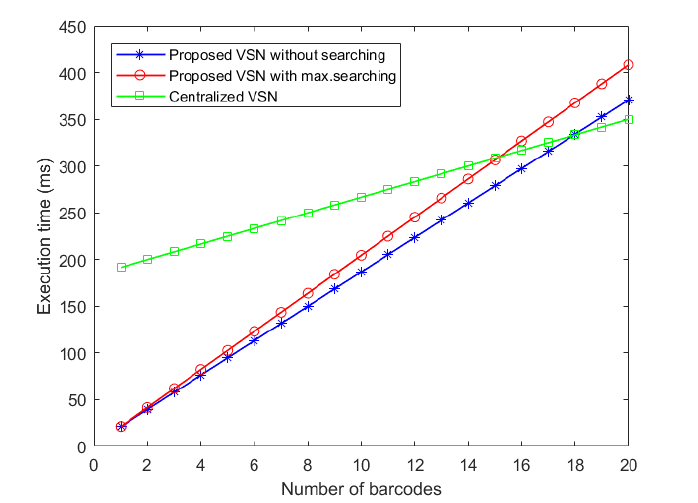
Figure 16. Execution time for the proposed and centralized camera tracking